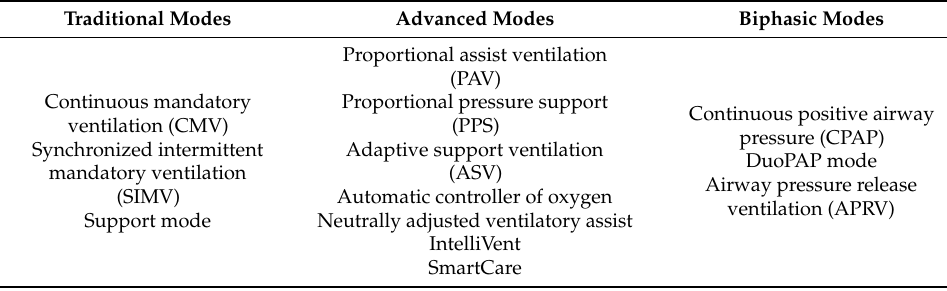
Table 1. Classification of modes based on IPPV